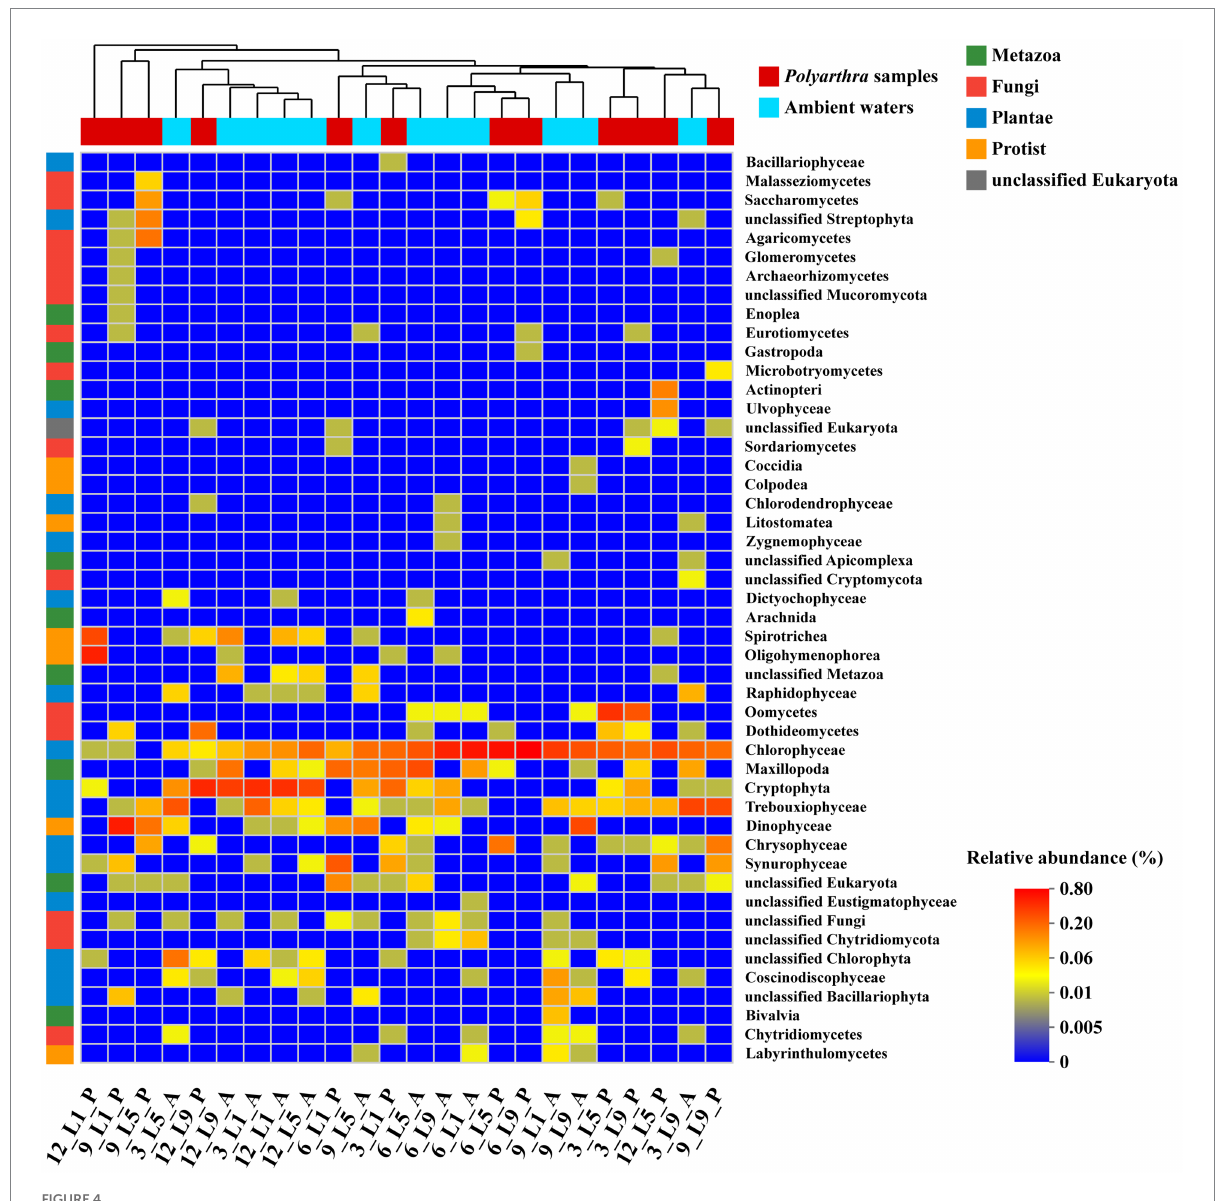
FIGURE 4 Heatmap analysis of eukaryotic communities between ambient water (A) and Polyarthra (P) based on Bray - Curtis distance (Top 50 abundant OTUs on Class level). Samples and taxa were automatically organized by hierarchical clustering. A: the ambient water samples; P: the Polyarthra gut contents samples; 12: December; 3: March; 6: June; 9: